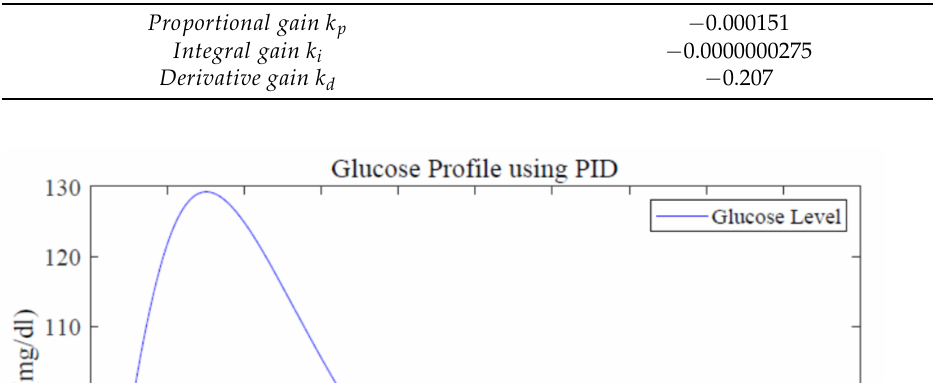
Figure 8. Root locus using the PID controller. Table 2. Parameters for the designed PID controller.